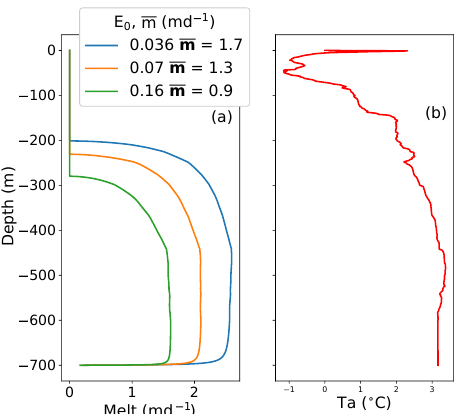
Figure 15. (a) Estimated subglacial discharge of Store Glacier for winter 2012/2013 from (Chauche, 2016). Red ranges give sub- glacial discharge estimates by the Motyka method and blue ranges by the Gade method and (b) the corresponding melt rate profiles. Simulated melt rates by the LP model with E 0 = 0 . 036 are depicted as the red dotted line (subglacial discharge from Motyka) and blue dotted line (subglacial discharge from Gade model).